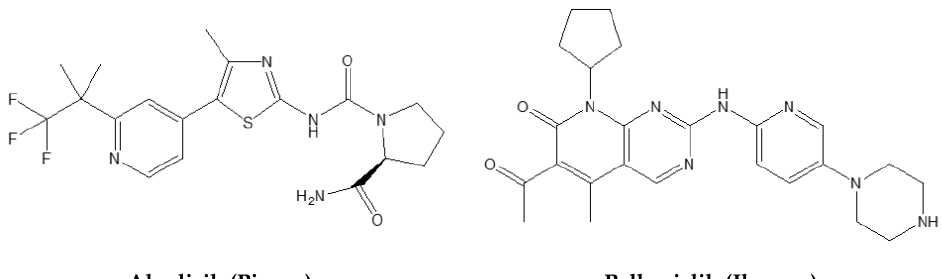
Figure 1. Molecular structures of Alpelisib (Alp) and Palbociclib (Pal).